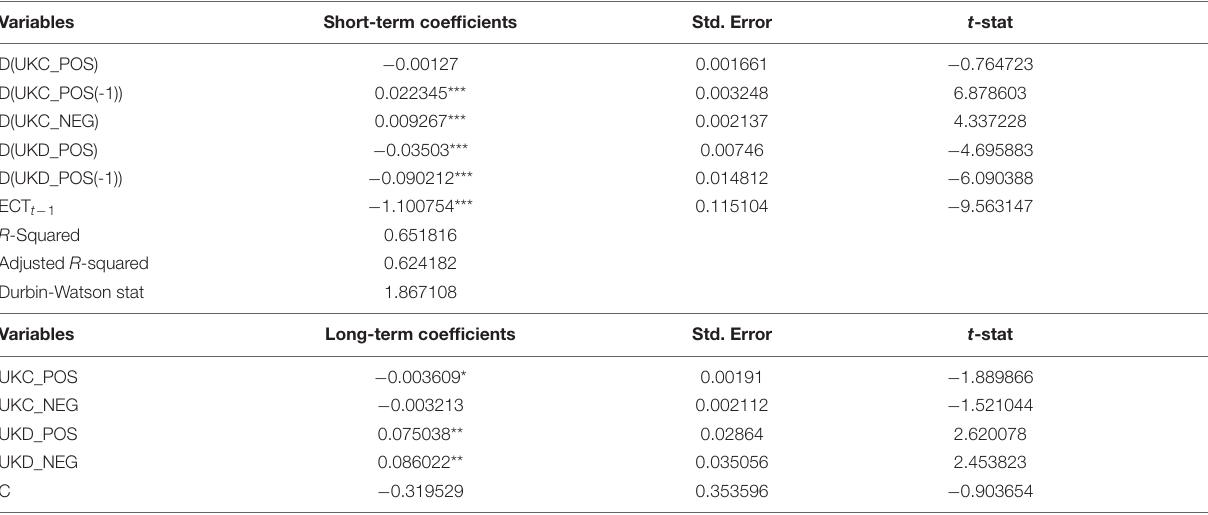
TABLE 10 | Asymmetric parameters of